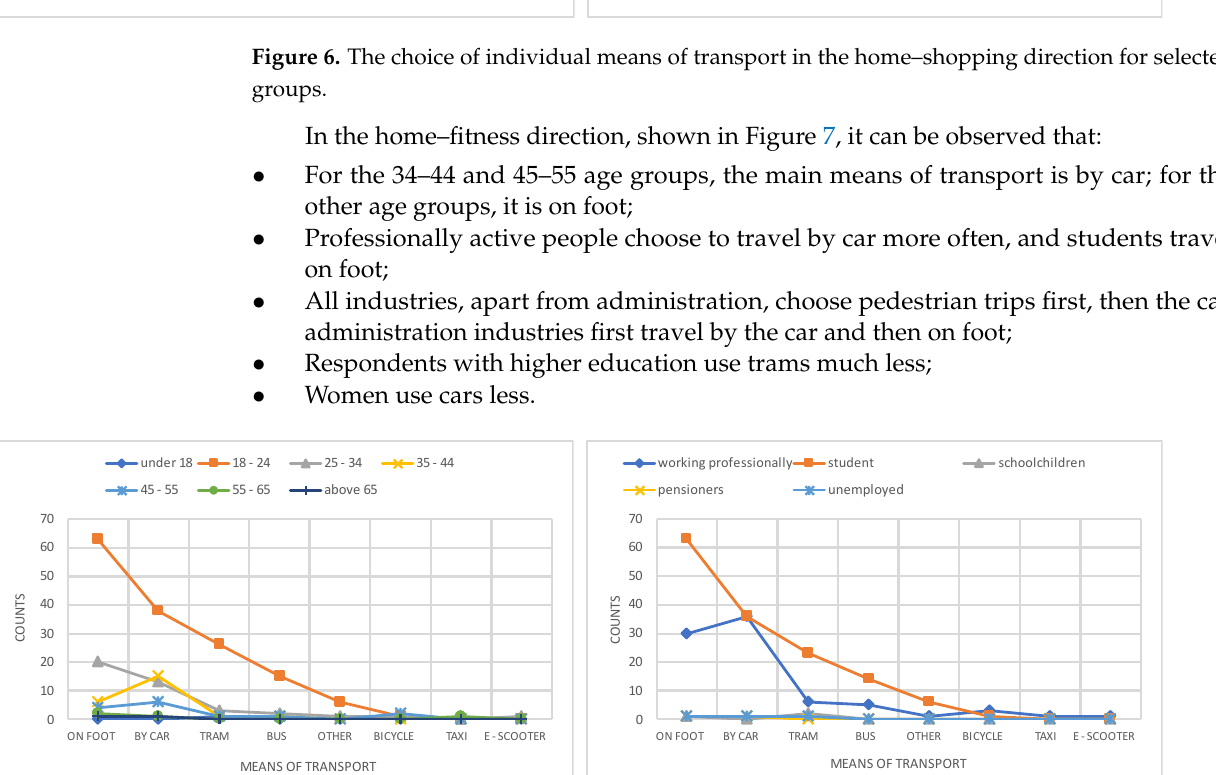
Figure 8. The choice of individual means of transport by users in the home – entertainment direction. In the home – cemetery direction, the distance was not covered on foot by the group of respondents aged 35 – 44. Among the surveyed groups, economically active people used the bus more often than others. Considering the respondents’ education, those with higher education chose to use buses more often, as shown in Figure 9. Figure 9. The choice of individual means of transport by users in the direction of Home – cemetery.